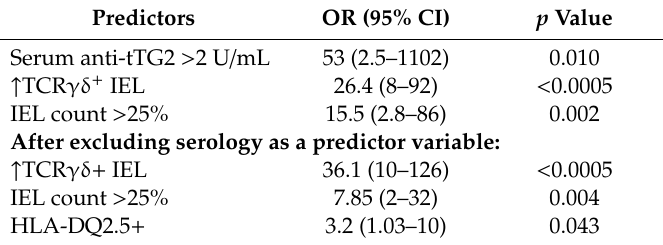
Table 2. Multivariate-adjusted logistic regression model ( n = 104): Predictor variables of low-grade coeliac enteropathy diagnosis.